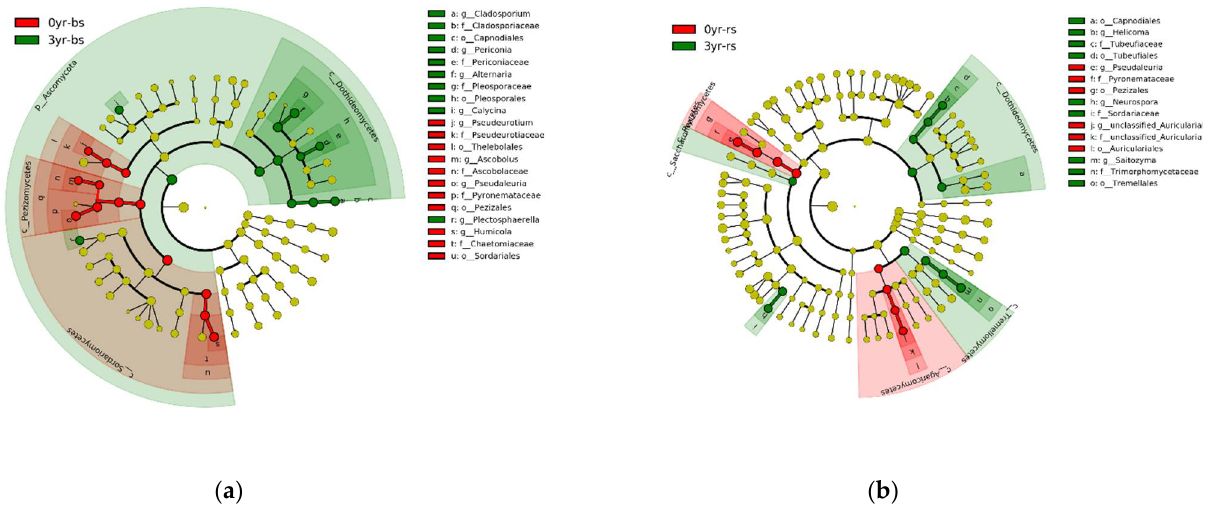
Figure 6. Phylogenetic dendrogram of biomarkers of the American ginseng rhizosphere when grown in soils with different monoculture history including bulk soil ( a ) and rhizosphere ( b ). 0 yr-bs: bulk soil with no American ginseng growing history; 3 yr-bs: bulk soil with 3-year monoculture; 0 yr-rs: rhizosphere in the soil with no American ginseng growing history; 3 yr-rs: rhizosphere in the soil with 3-year monoculture. Only biomarkers with LDA > 3.8 are displayed (Kruskal–Wallis rank-sum test, p < 0.05).